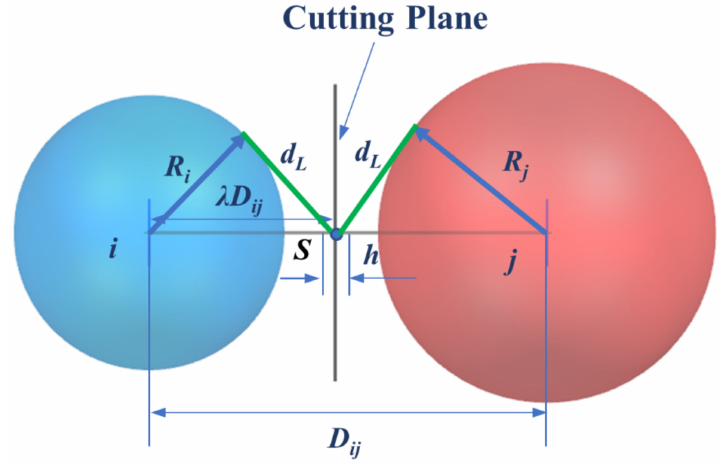
Figure 1. Schematic of the improved Laguerre–Voronoi tessellation, R i , R j are the radii of the power circles corresponding to the adjacent nucleus, D ij is the distance between nuclei, h is the thickness of the grain boundary, and the point S is the location of the cutting plane between two nuclei, λ is the ratio of the distance from point S to nucleus i to D ij , d L is the tangential distance from point S to two